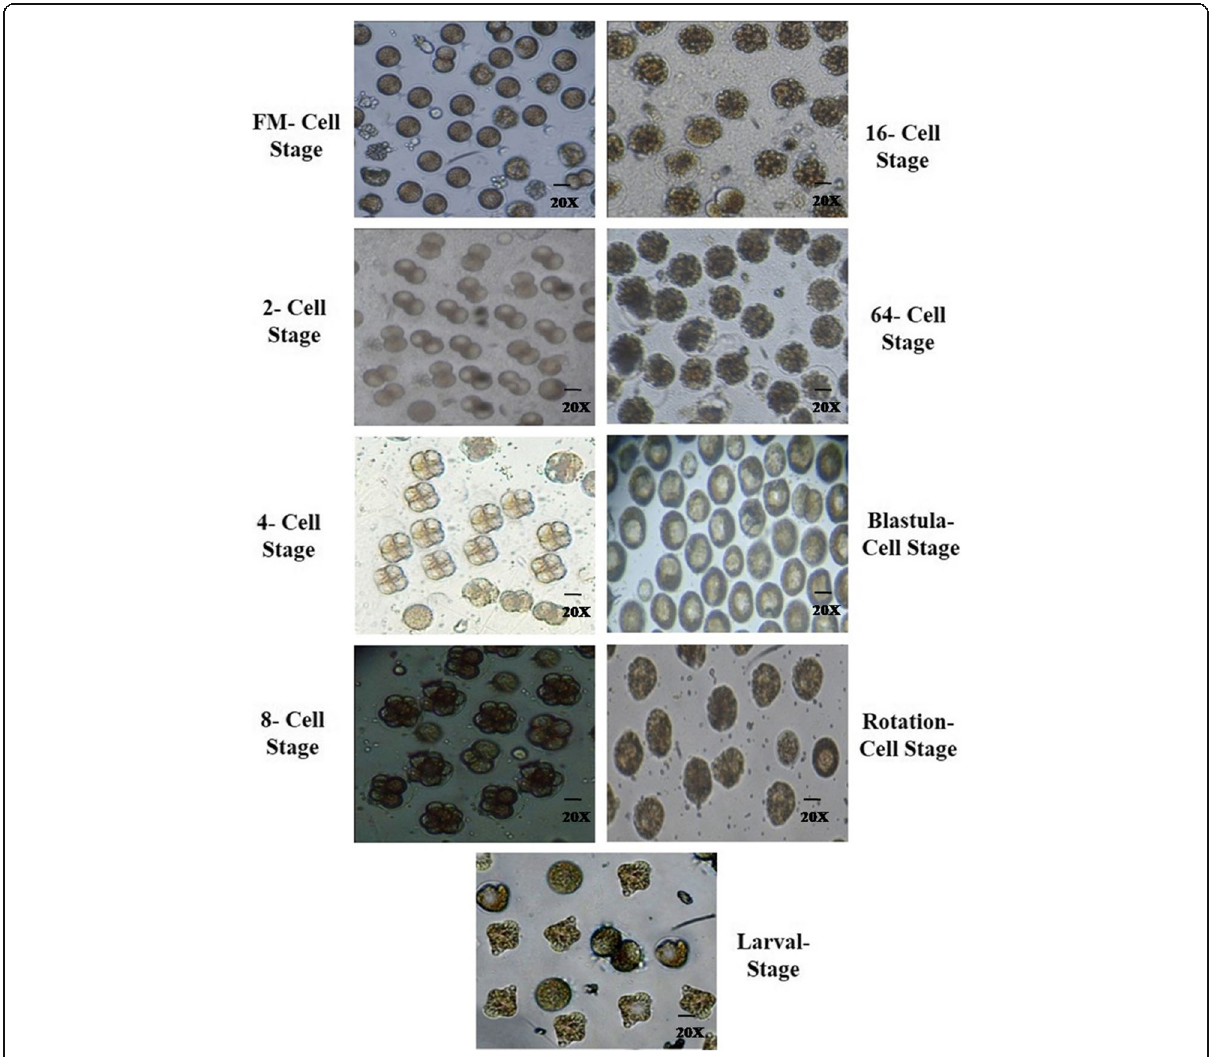
Fig. 3 Fertilization and early developmental stages of Hydroides elegans in